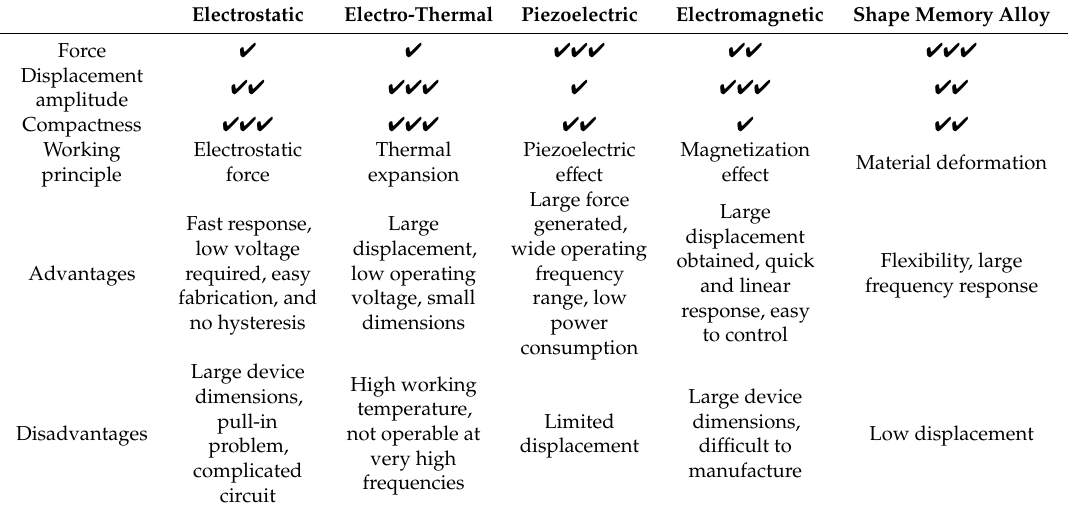
Table 4. The performance of di ff erent actuation methods.